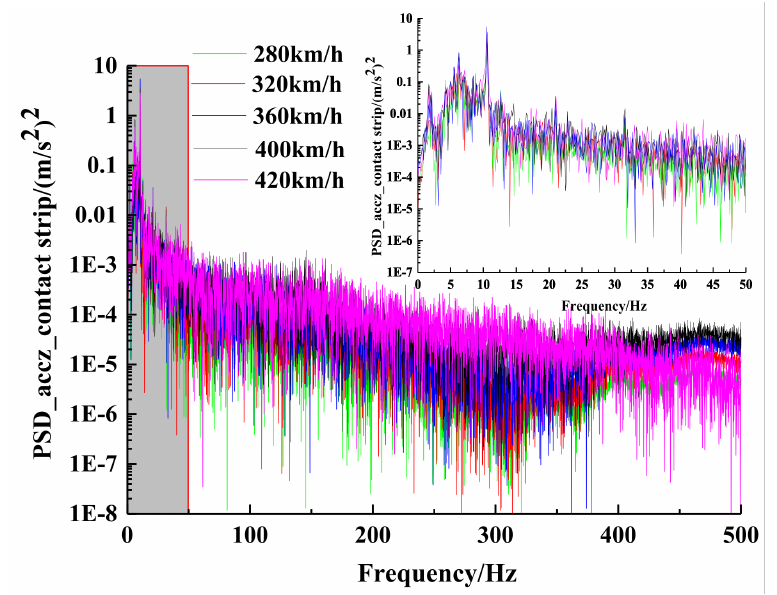
Figure 17. Power spectral density curves of vertical acceleration of the contact strip passing through tunnel at different